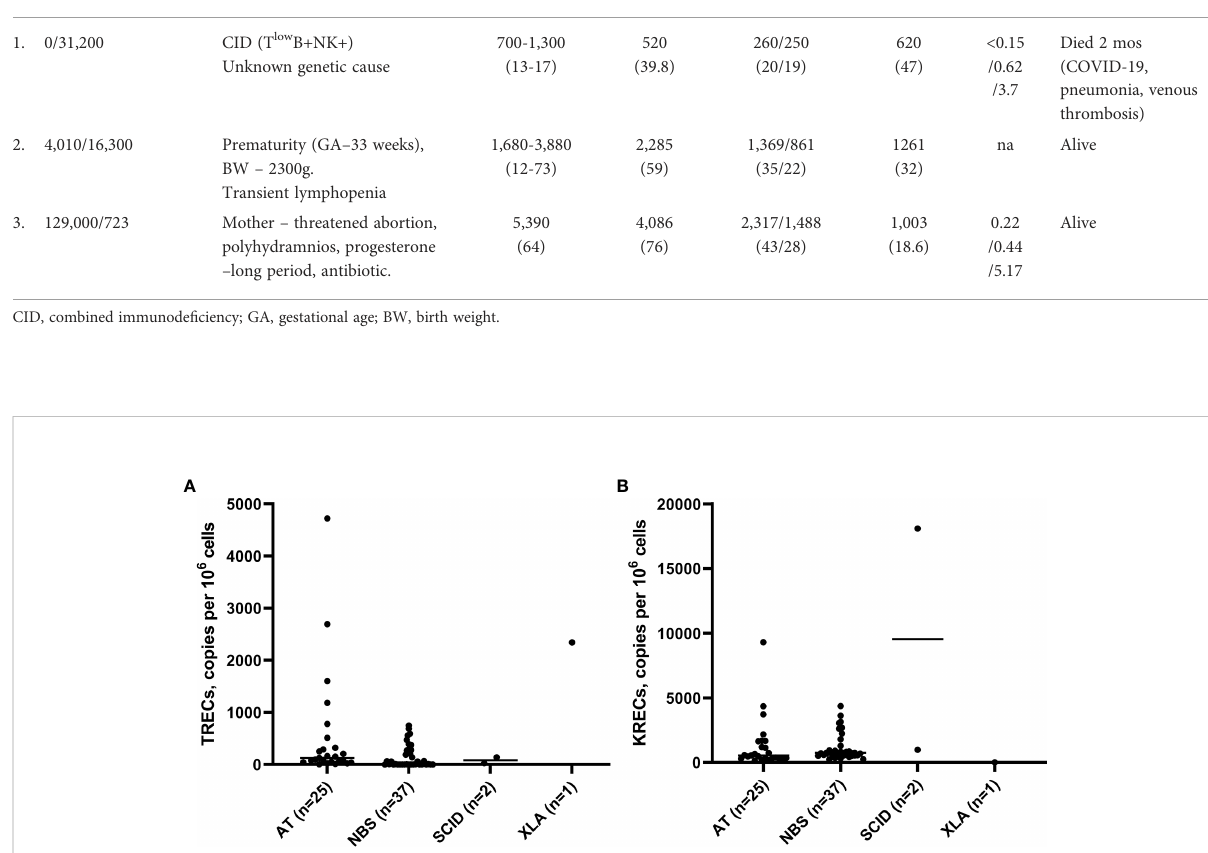
TABLE 3 Characteristics of patients with abnormal value (urgent abnormal value and abnormal value in new sample test). N TRECs/KRECs, copies per 10 6